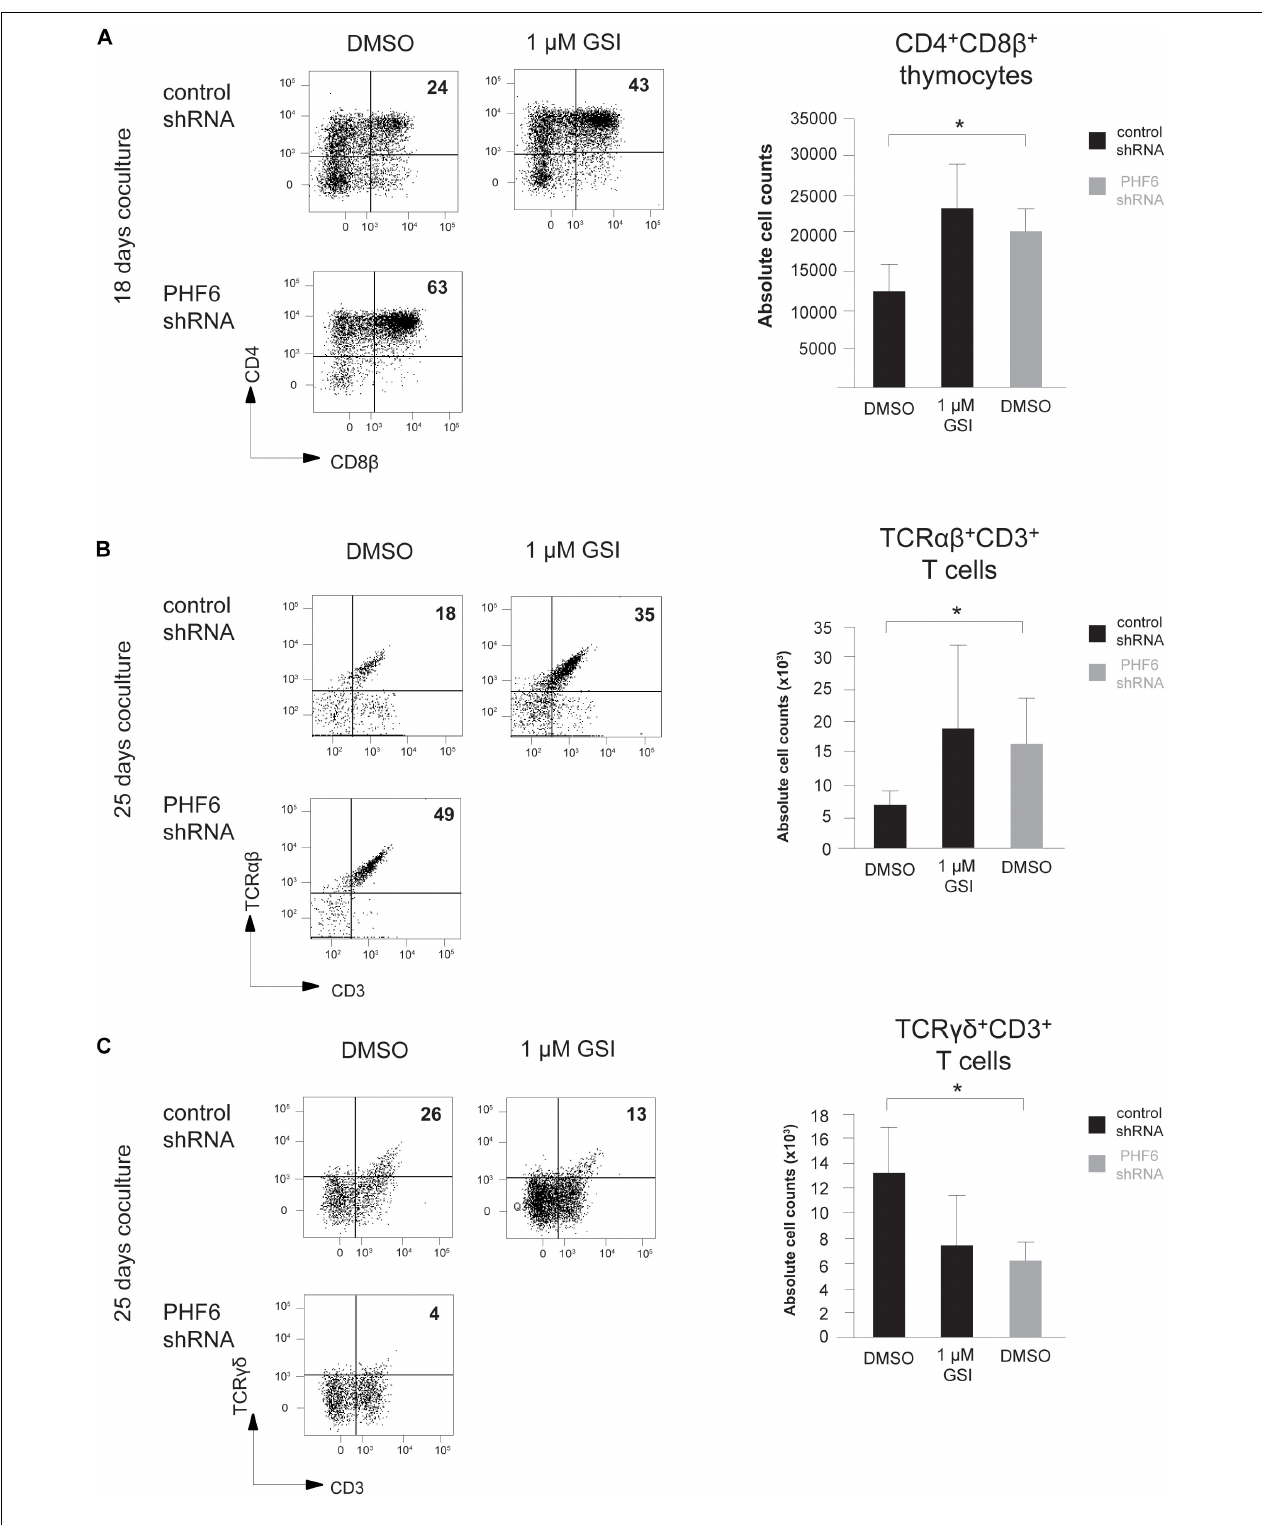
FIGURE 6 | Loss of PHF6 mimics reduced Notch activity during human T cell development. (A–C) ( left ) Flow cytometry analysis and ( right ) absolute cell counts of control versus PHF6 shRNA transduced or DMSO versus 1 µ M GSI treated CD34 + thymocytes in OP9-DLL1 cocultures showing (A) the development of CD4 + CD8 β + DP thymocytes after 18 days of coculture, (B) the development of CD3 + TCR αβ + thymocytes after 25 days of coculture and (C) the development of CD3 + TCR γδ + thymocytes after 25 days of coculture. Data shows the average of 3 independent experiments and errors bars show SEM. * P < 0.05 (paired t -test).